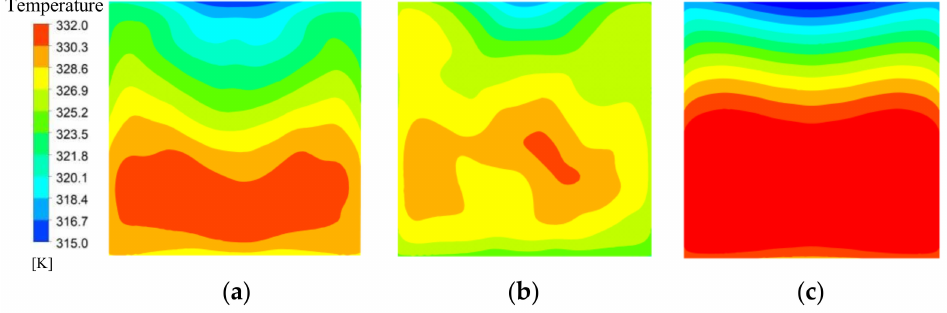
Figure 8. Temperature contours for u f in = 0.7 m/s. ( a ) M1; ( b ) M2; ( c )